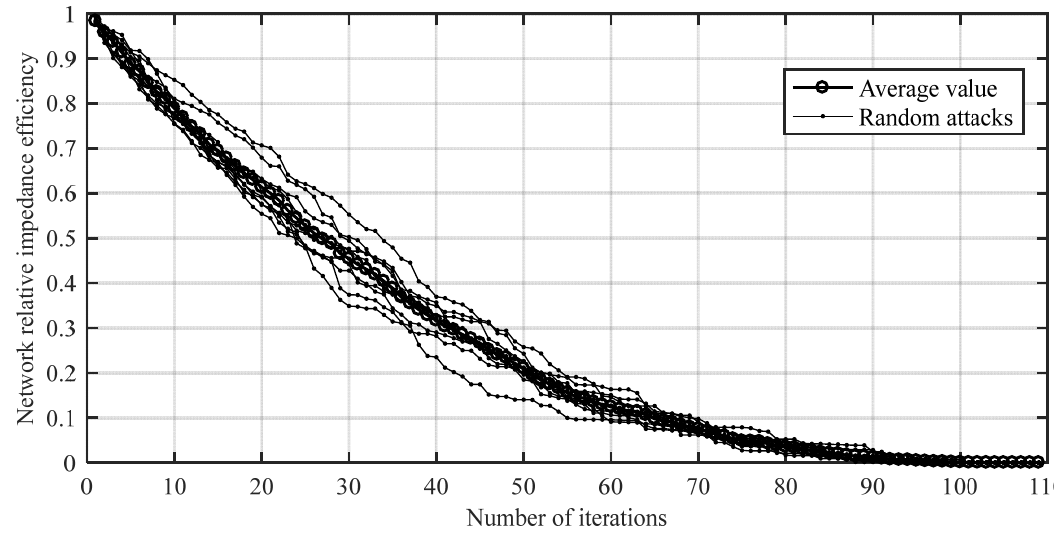
Figure 7. The trend of network performance of attacking nodes randomly.